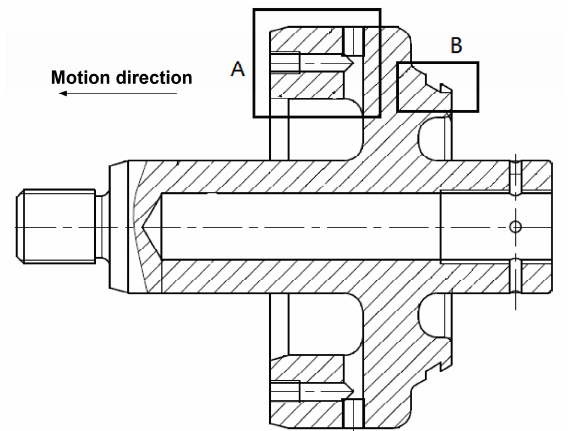
Figure 2. Structure of hydraulic piston with T-shaped